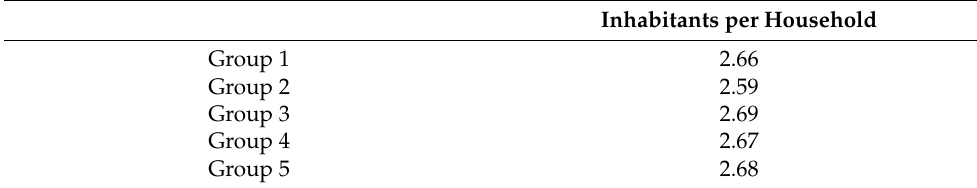
Table 2. Inhabitants per household in each